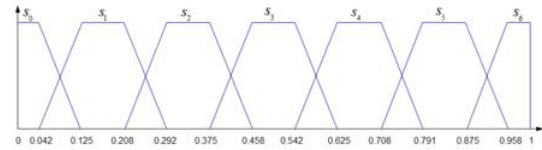
Fig. 1. A set of seven terms with their